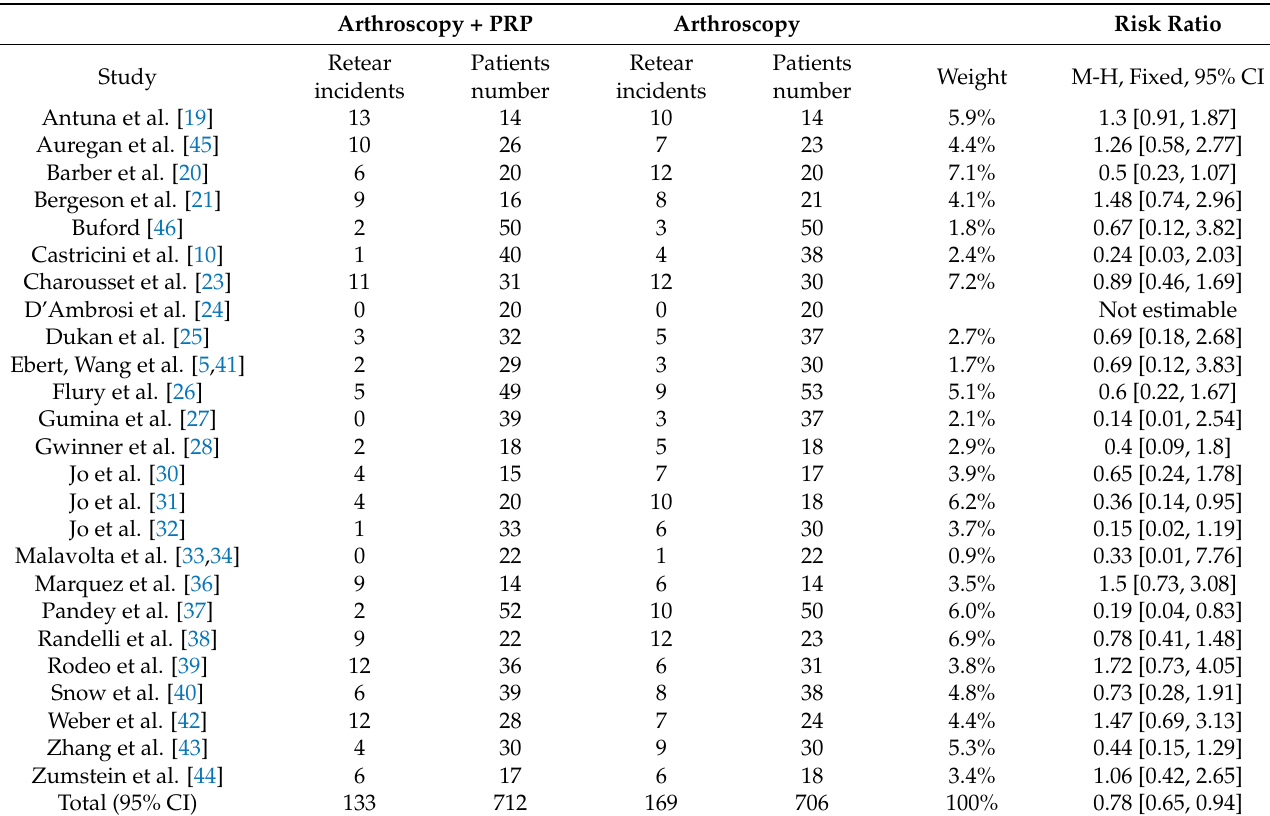
Table 7. Comparison of post-operative retear rates between PRP and control groups at final follow-up. Arthroscopy + PRP